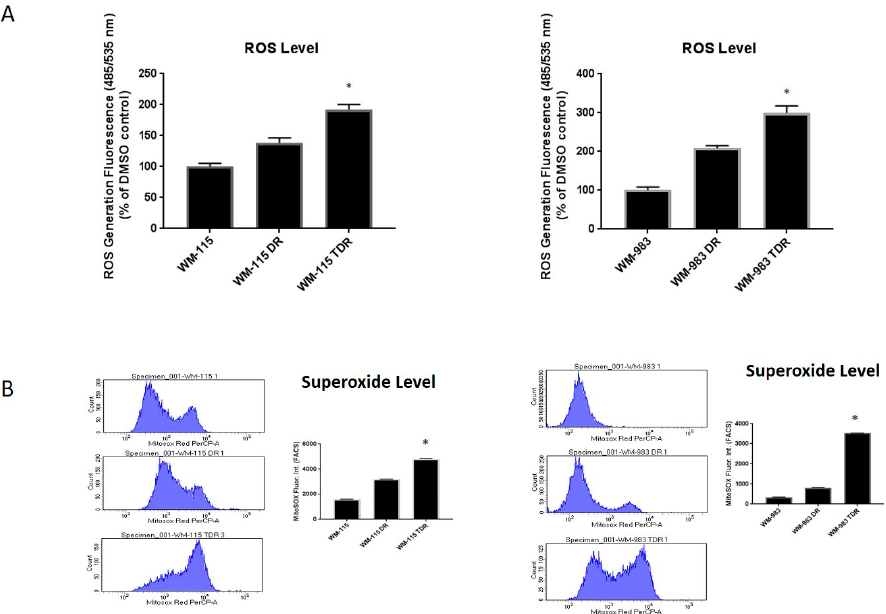
Figure 2. ROS level is upregulated upon BRAF and MEK inhibitor resistance. ( A ) ROS levels in WM-115 (parental, dabrafenib-resistant (DR), and trametinib- and dabrafenib-resistant (TDR) and WM-983 (parental, DR, and TDR) were measured by the DCFDA assay. ( B ) Basal superoxide levels in WM-115 (parental, DR, and TDR) and WM-983 (parental, DR, and TDR) cells were measured by the MitoSOX assay. * p < 0.05 versus parental cell lines. Statistical analysis by one way ANOVA. 2.3. BRAF Mutant Melanoma Cells Resistant to BRAF and MEK Inhibition Show Increases in DNA